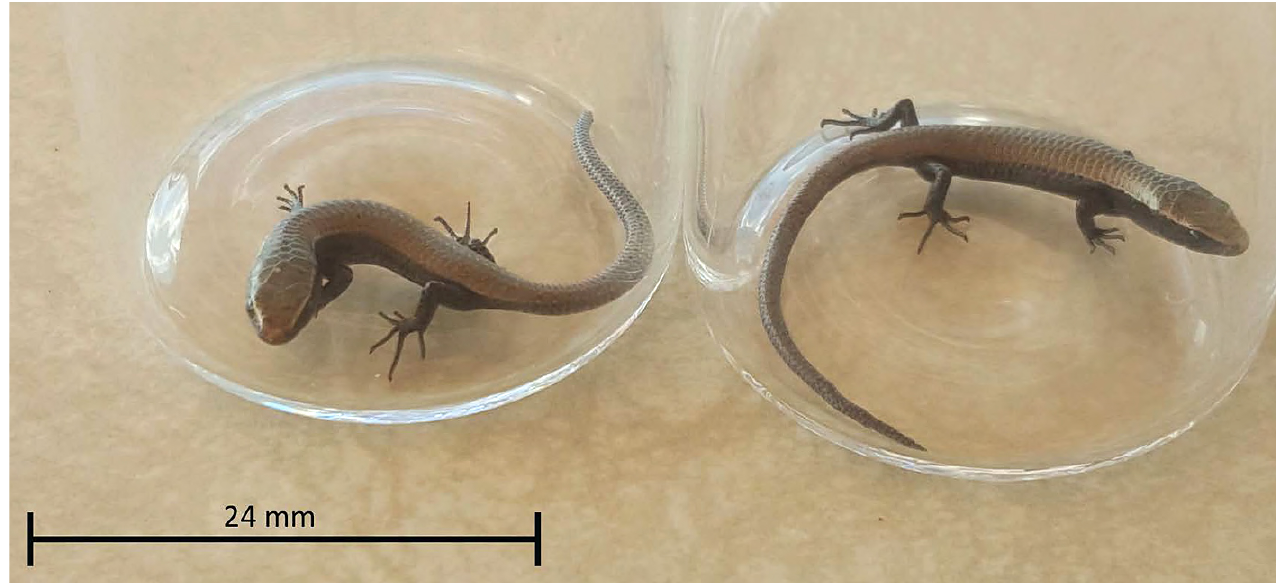
Figure 3. Hatchling Gymnophthalmus underwoodi specimens collected for analysis.